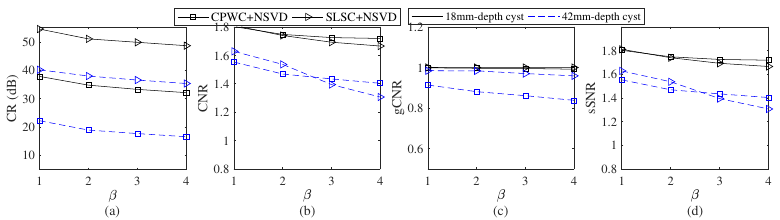
Figure 18. Effect of the β value on ( a ) CR, ( b ) CNR, ( c ) gCNR, and ( d ) sSNR in simulated cyst target images.